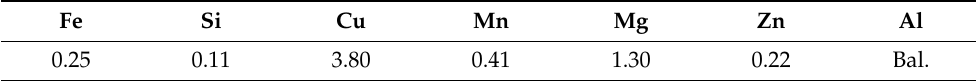
Table 1. Chemical composition of Aluminum Alloy 2024 (wt%) used in the study. Fe Si Cu Mn